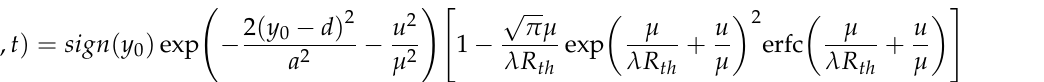
It can be seen from the results that there are significant temperature changes at the crack, so the temperature gradient can be used as the characteristic quantity to describe the shape and geometric distribution of the crack. The thermal conductivity has a significant effect on the temperature field amplitude and gradient. Note that the thermal gradient amplitude of titanium alloy material is the largest, and the crack characteristics are easier to be extracted. When studying the influence of laser power, a nickel-based alloy is selected as the model material and the total energy using the model is set as Q 0 = 100~600 mJ, and other parameters remain unchanged. As shown in Figure 3d, the temperature abruptness at the crack is sharper with the increase in laser